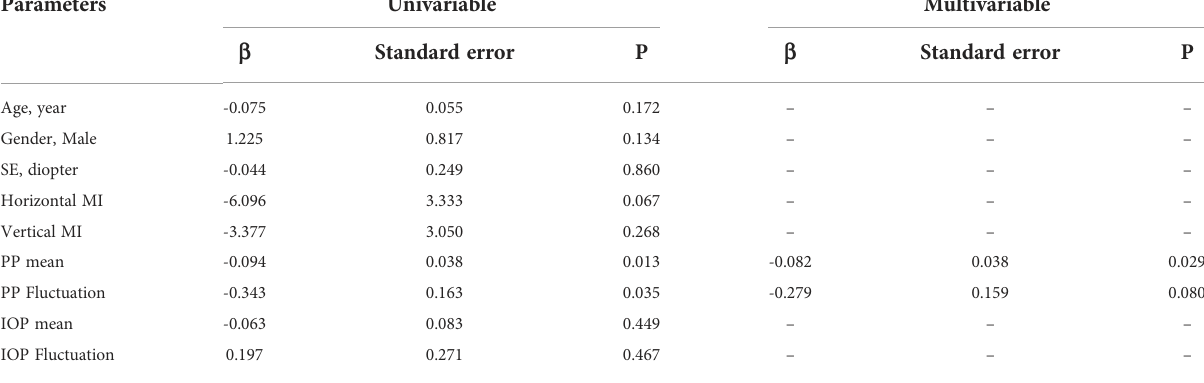
TABLE 4 The GEE analysis with RPC as the predictor factor.